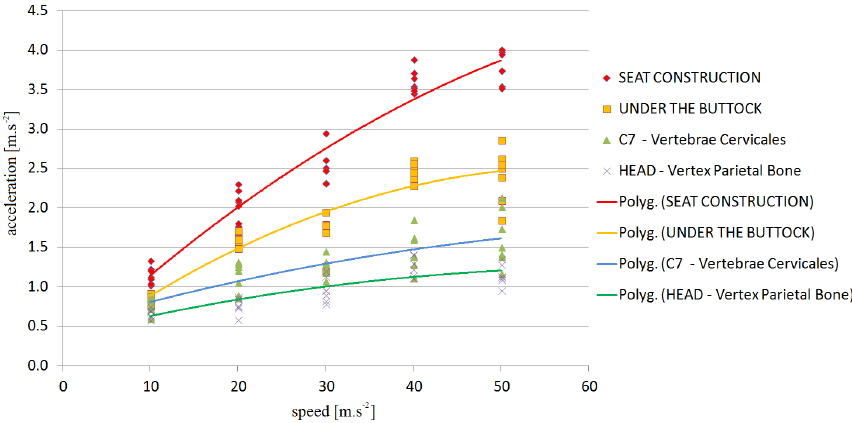
Figure 8. CO-DRIVER-dependence of vehicle speed on acceleration—V36 to V70.